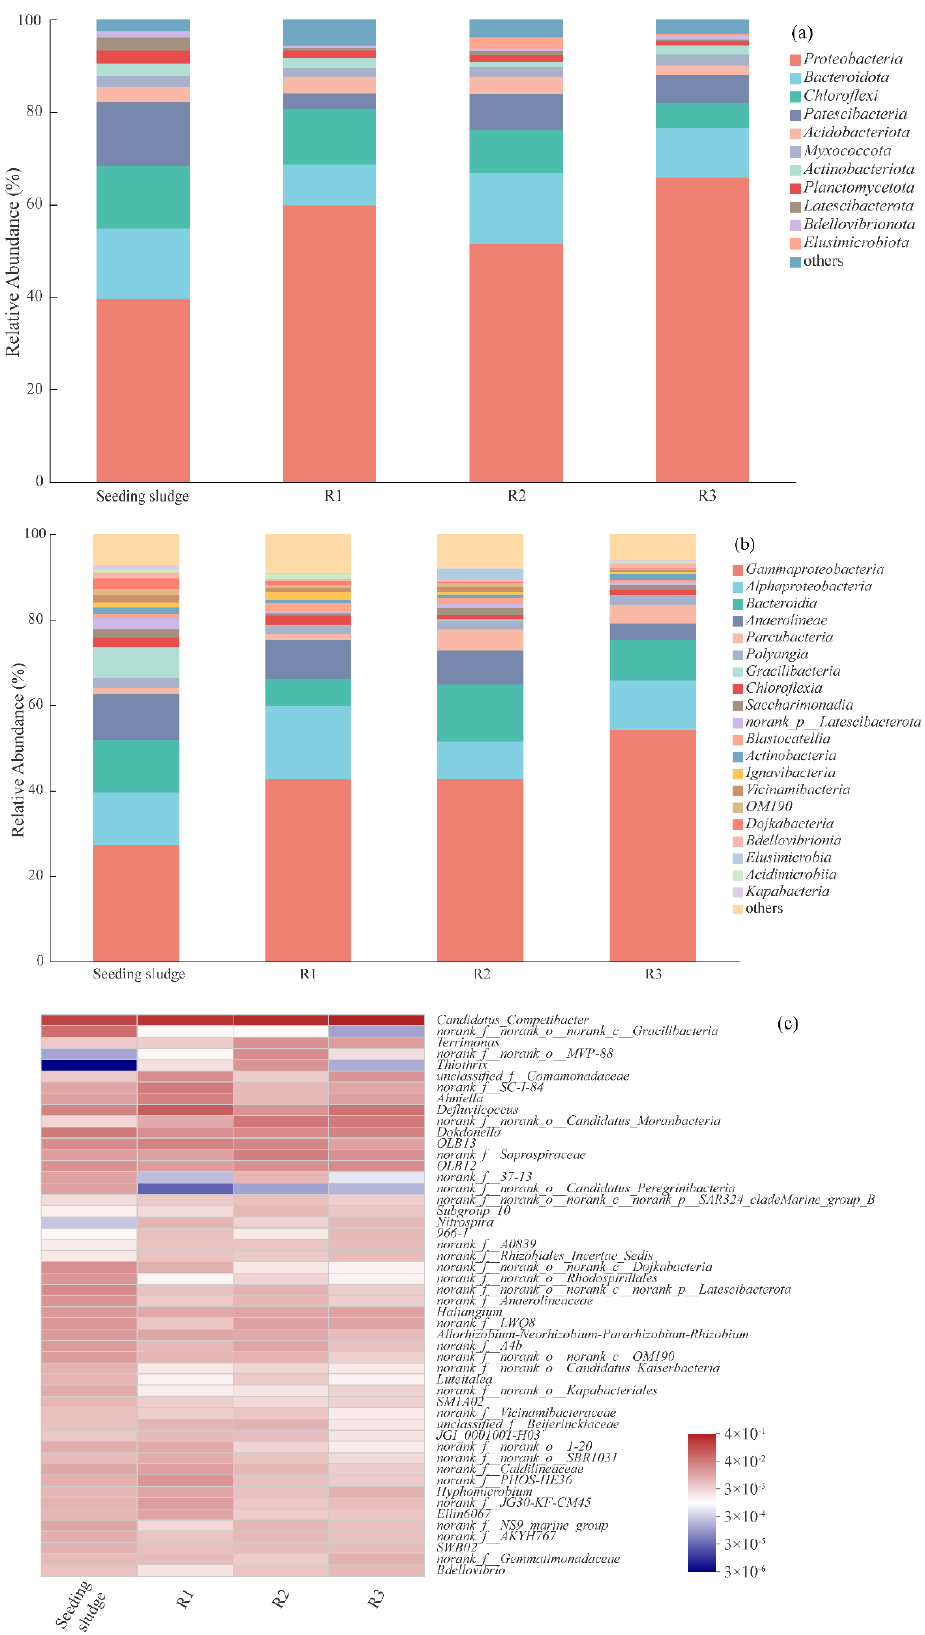
Figure 6. ( a ) The percent of community abundance on phylum level. ( b ) The percent of community abundance on class level. ( c ) The heatmap of microbes at the genus level.